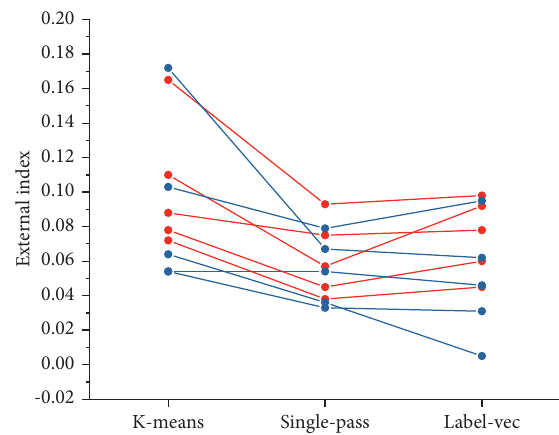
Figure 6: Comparison of external index metrics of different